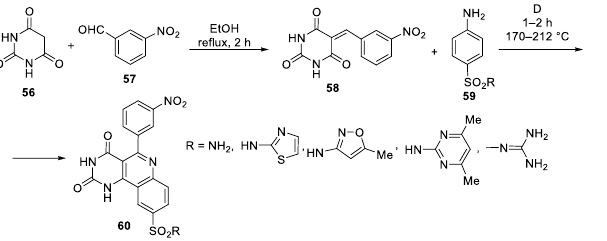
Scheme 12. The synthesis antiviral sulfonamide derivatives of 5-(-3-nitrophenyl)pyrimido[ 5,4- c